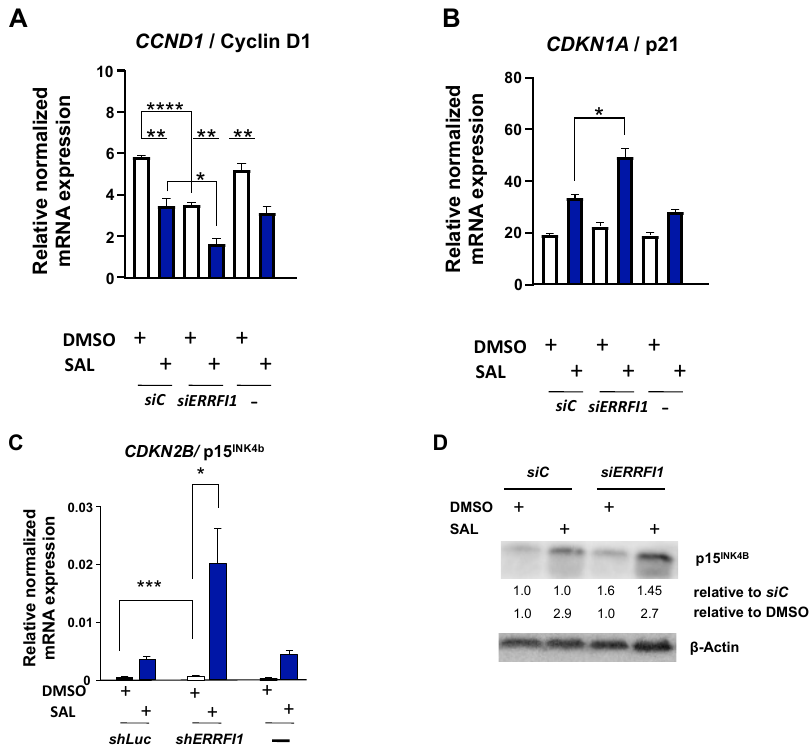
Figure 7. siRNA mediated knockdown of ERRFI1 enhances levels of cell cycle inhibitors. ( A – C ) qRT- PCR were performed for analysis of mRNA expression of CCND1 ( A ), CDKN1A ( B ) and CDKN2B ( C ). The expression was normalized to housekeeper mRNAs of TBP and GAPDH . The mean and SEM values were calculated from 3 biological replicates. ( D ) The protein expression of p15 INK4b was normalized to the loading control β -actin using LabImage 1D software.